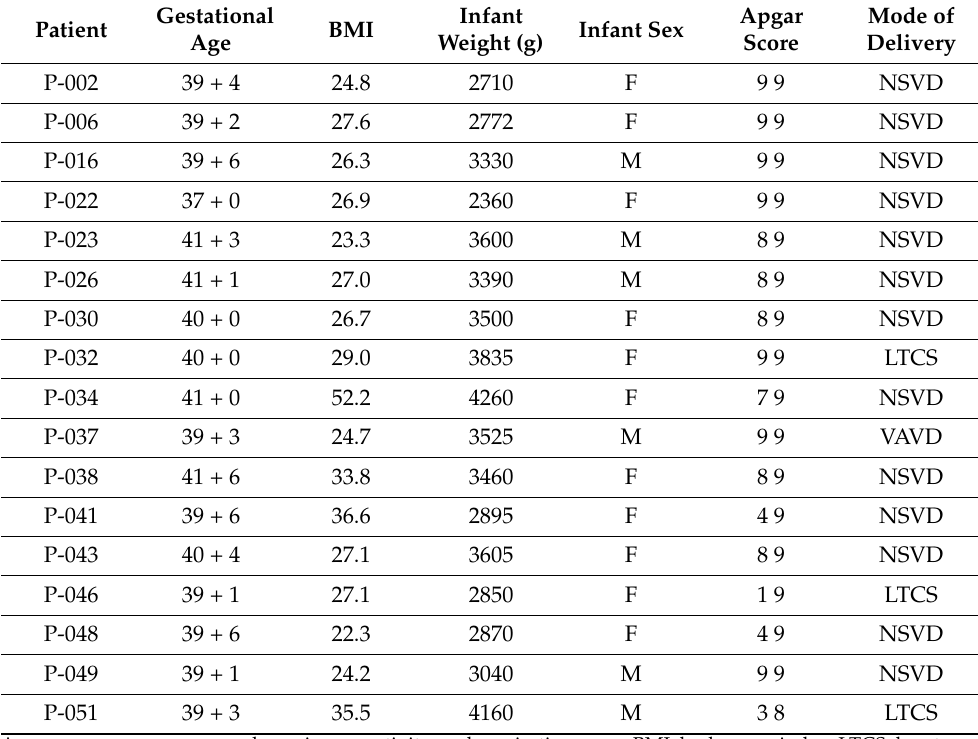
Table 1. Study population